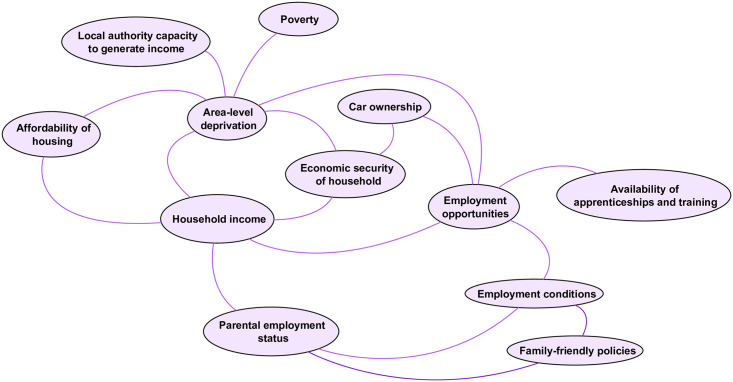
The economic domain.